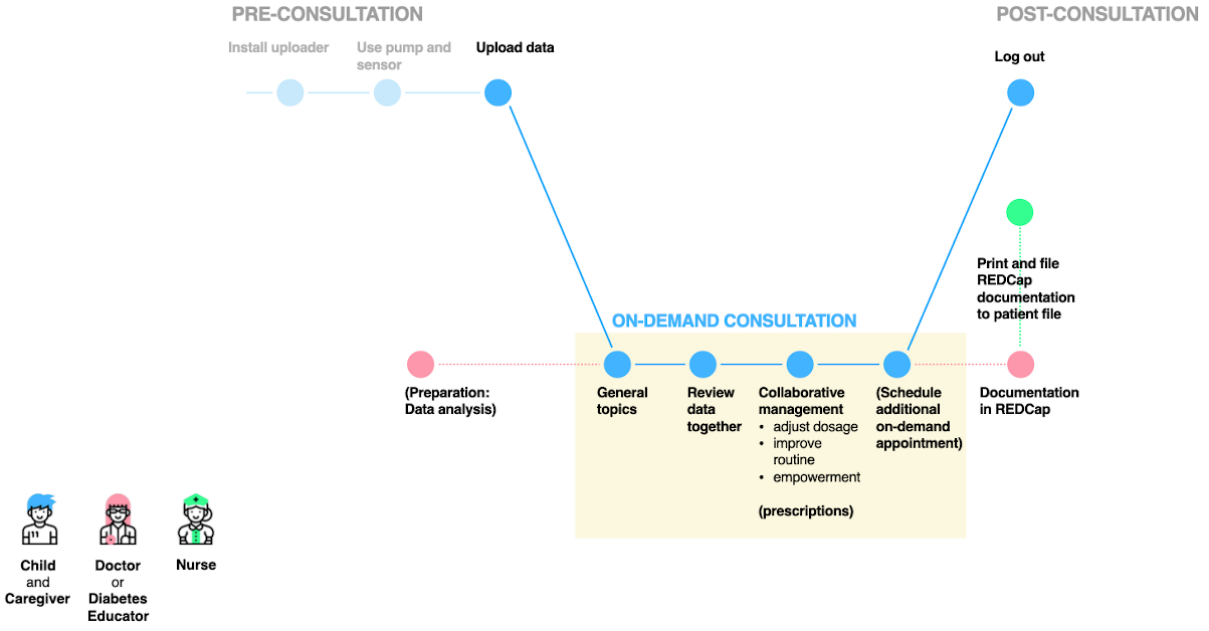
Figure 4. The patient experience and the workflow of remote, on-demand consultations (ie, those conducted between monthly check-ins). REDCap: Research Electronic Data